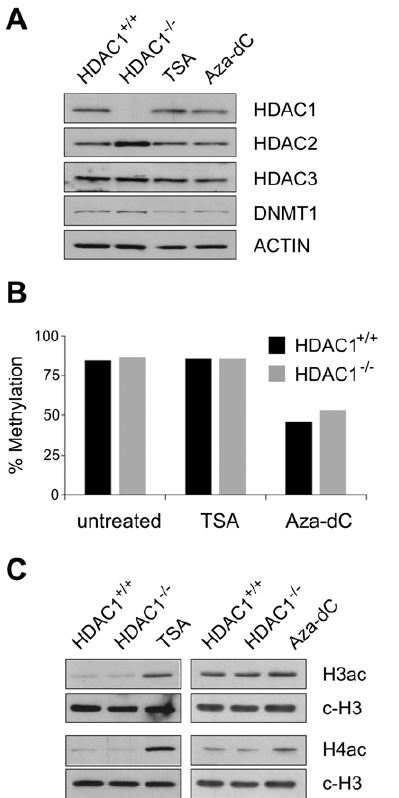
Figure 1. Effects of HDAC1 depletion, TSA treatment, and Aza- dC treatment on DNA–methylation and histone acetylation patterns in mouse fibroblasts. Mouse wildtype fibroblasts were left untreated (HDAC1 + / + ) or treated with TSA (166nM; 24h for (A) and (B); 3h for (C)) or Aza-dC (1 m M for 24h; 24h recovery). In addition untreated HDAC1 deficient fibroblasts (HDAC1 2 / 2 ) were included in these experiments. (A) Western blot analysis of chromatin modifying enzymes. Proteins were extracted, separated by SDS-PAGE and analysed with antibodies specific for HDAC1, HDAC2 and DNMT1. Equal loading was controlled with an antibody raised against b -ACTIN. (B) DNA methylation of IAP retrotransposons in HDAC1 + / + (black bars) and HDAC1 2 / 2 (grey bars) fibroblasts. Both cell lines were treated with TSA or Aza-dC as described above. Average DNA methylation levels of three CpG sites within the LTR were determined employing the Ms-SNuPE technique. (C) Analysis of histone acetylation patterns. Histones were extracted and analysed on Western blots using H3ac and H4ac specific antibodies. Equal loading was monitored with an antibody recognising the C-terminus of histone H3